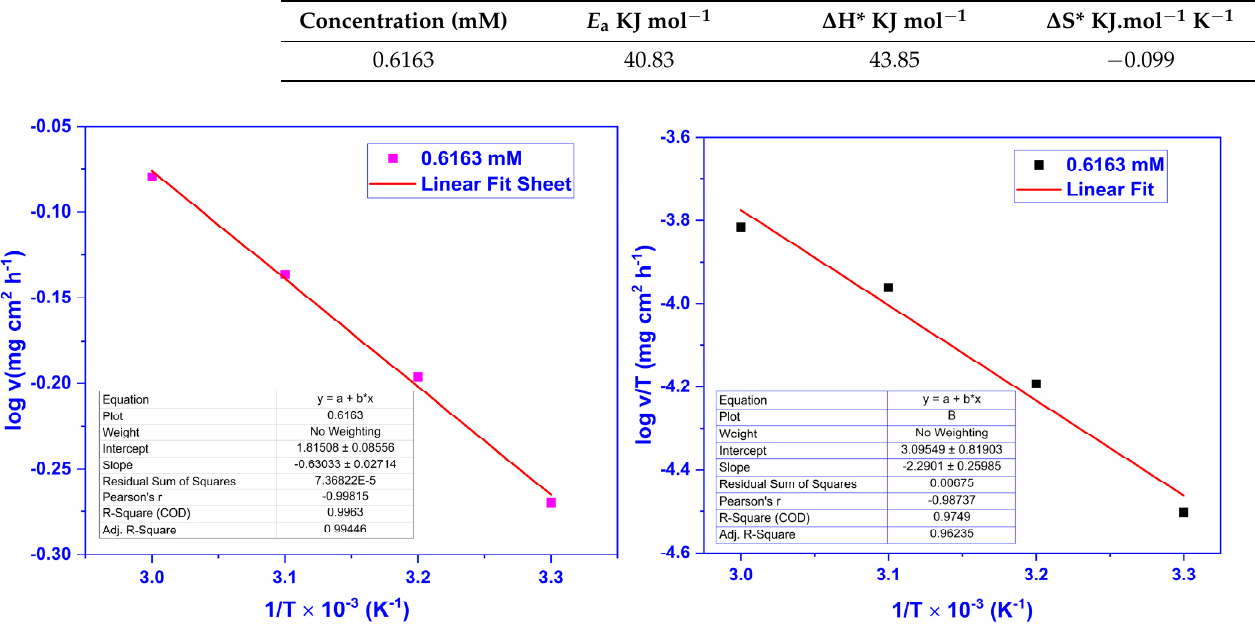
Table 2. Activation parameters obtained for MS corrosion in 1 M HCl solution in the 0.6163 mM CMEA.